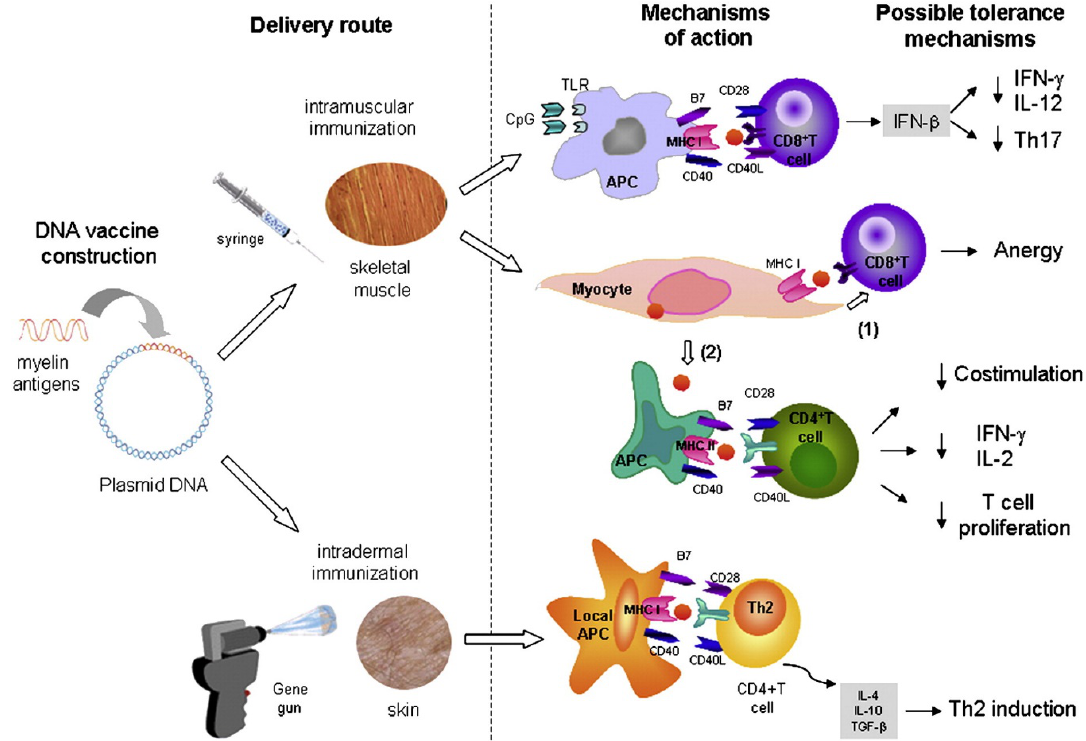
Figure 7. Mechanisms of immune tolerance induction by DNA plasmid vaccines (with permission of [139]).